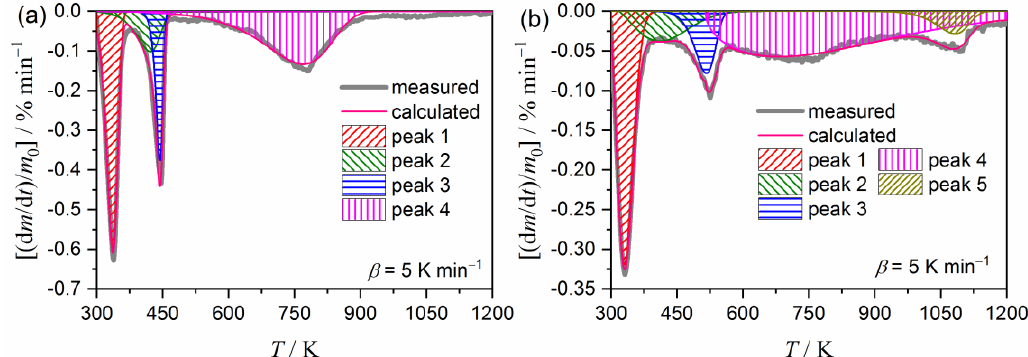
Figure 6. Typical results of MDA applied to the multistep thermal decomposition of the clay minerals: ( a ) Palygorskite and ( b ) sepiolite.